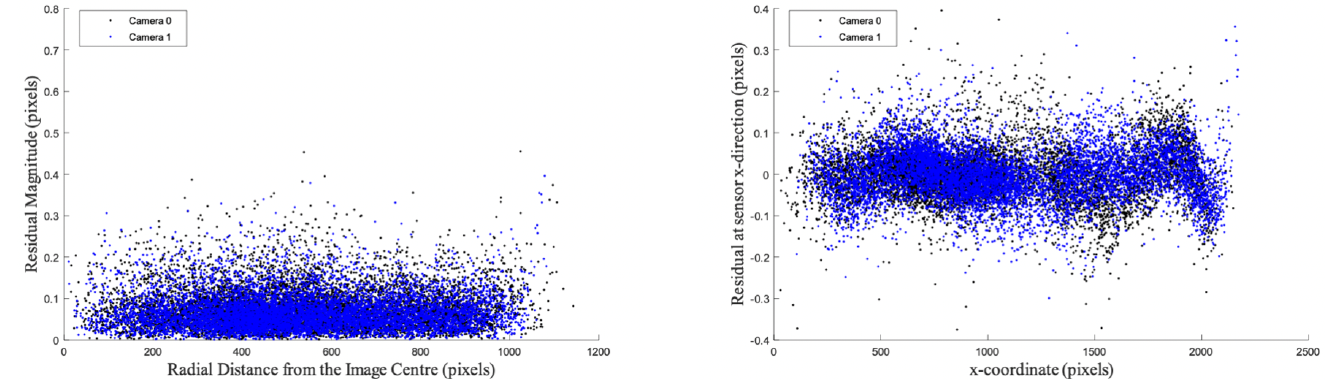
Figure 14. Unmodelled systematic errors in the residuals when using the manufacturer’s calibration model and re-calibrated parameters. ( Left ) The magnitude of the residuals. ( Right ) The x-component of the